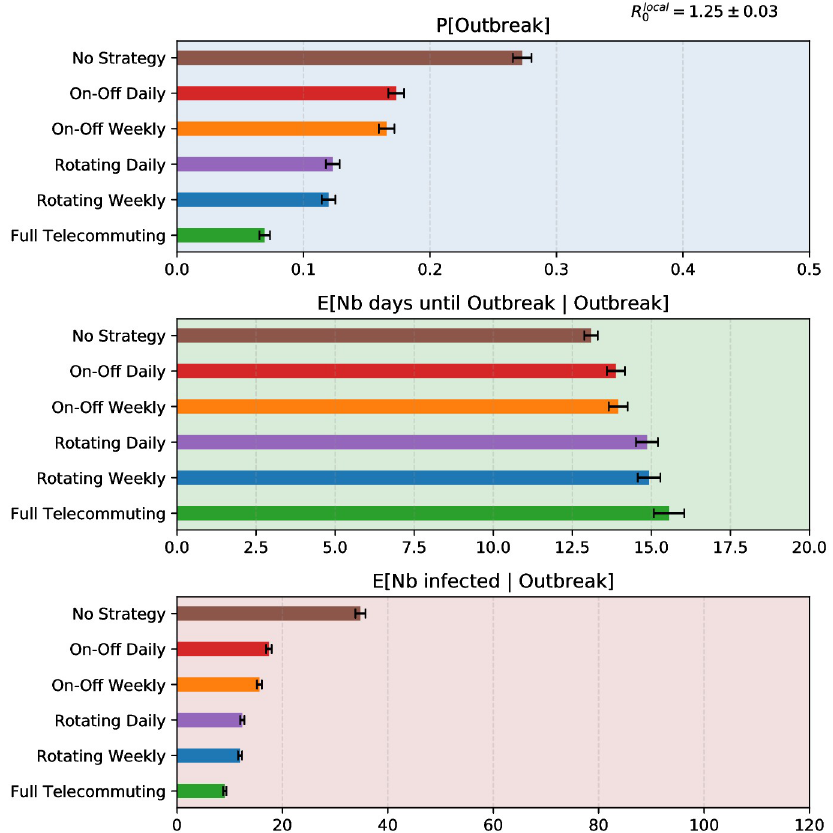
Fig 3. Comparison of the effects on SARS-CoV-2 outbreak of containment strategies implemented in the contact ¼ 1 : 25 . The three panels respectively correspond to three relevant metrics: (top) graph of a high school when R local 0 the probability that at least 5 people are infected besides patient 0 (which we define as ‘Outbreak’ event); (middle) the average number of days until 5 people are infected besides patient 0, conditioned on the occurrence of outbreak; (bottom) the average total number of people infected in the population in case of outbreak. That number is a random variable that has a large standard deviation, but with probability 95% its expectation lies within the error